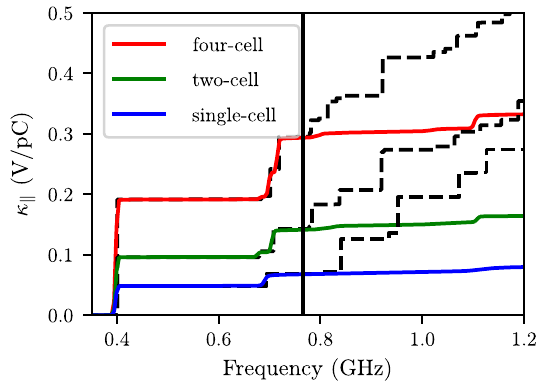
FIG. 5. The loss factor as a function of frequency obtained from ABCI code for different number of cells. The dashed lines are the calculated loss factors from CST EMS results using Eq. (9). The solid vertical line is the cutoff frequency for the beam pipe radius ¼ 765 MHz). of 15 cm ( f cut